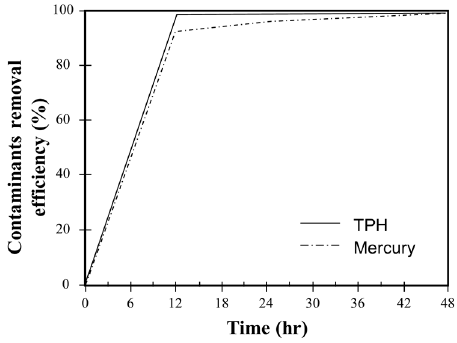
Figure 7. Removal efficiency of TPH and mercury.